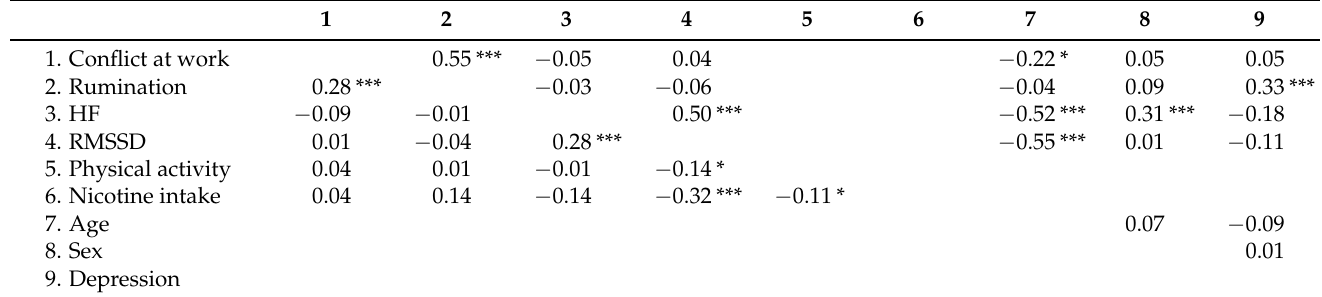
Table 1. Means, standard deviations, and standardized zero-order correlations.